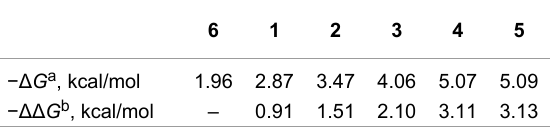
Table 3: Contribution of polyether oxygen atoms of molecular clips 1 – 5 to the binding of paraquat. 6 1 2